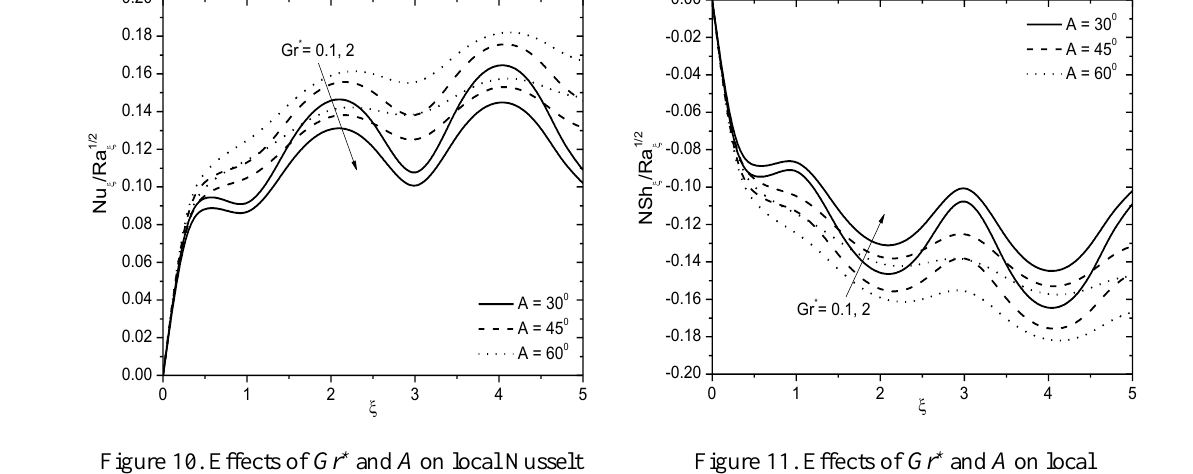
Figure 10. Effects of Gr * and A on local Nusselt number